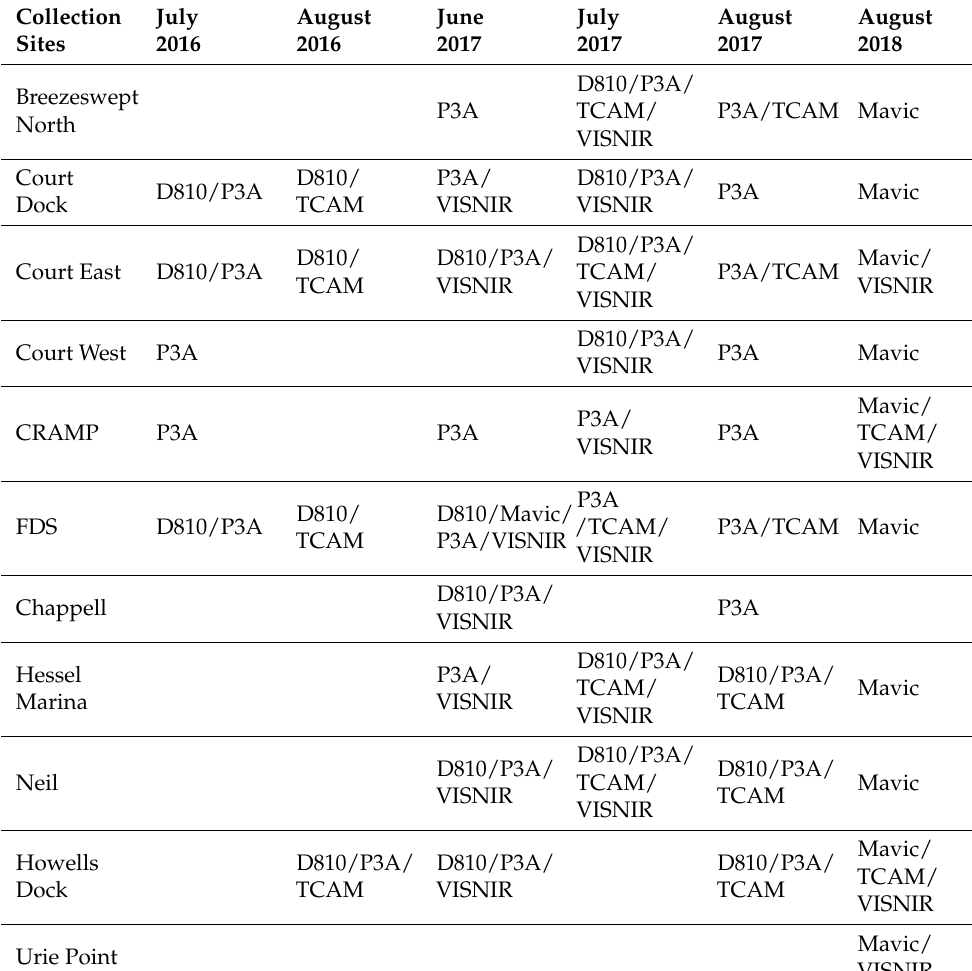
Table 1. Collection sites and sensors deployed by date in the Les Cheneaux Islands from 2016 to